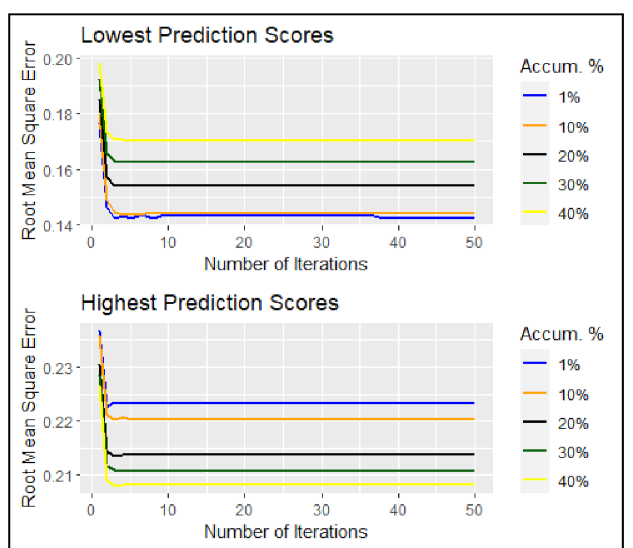
Figure 2. The highest and lowest prediction scores for all observed response Y within 50 iterations ( D = 50) obtained with the RiskLogitboost